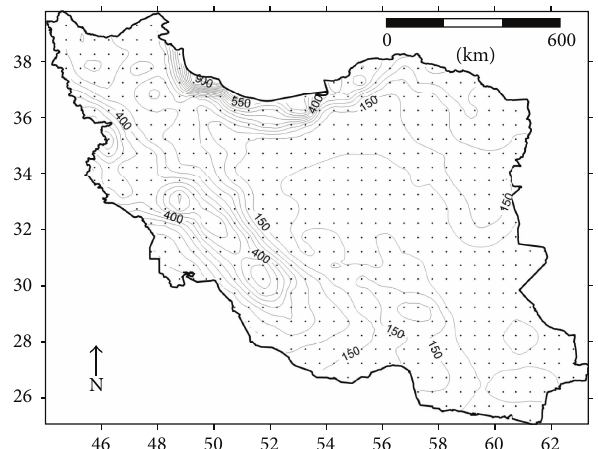
Figure 2: Location of 42 meteorological stations in Iran used in this study.